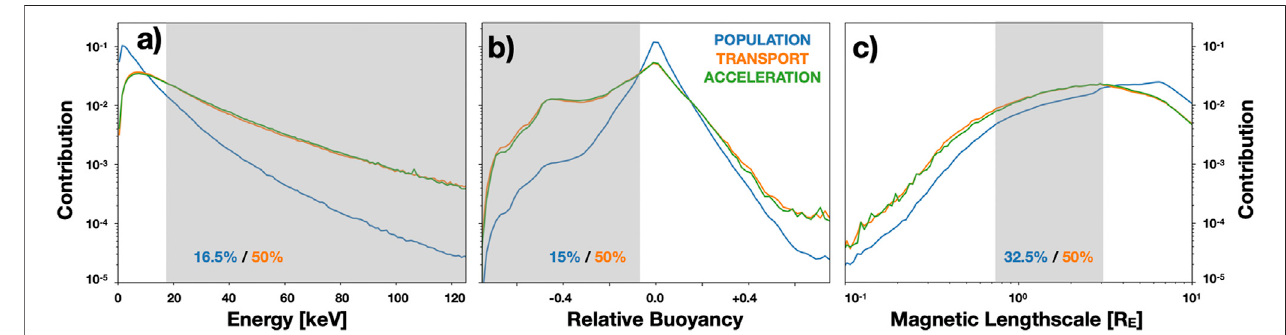
FIGURE 4 | Ef fi ciency of transport and acceleration in the transition region. Here we compare for various particle and fl ow properties their fraction of: the total population,thetotalinwardenergytransport,andthetotalenergizationasde fi ned in Section2.3 .Regionswhere thecontributionofaquantitytotransport/acceleration is greater than population are “ ef fi cient ” for ring current buildup. Shown are particle energy (A) , relative buoyancy Eq. (2) ; (B) , and magnetic lengthscale Eq. (4) ; (C) . In each panel the shaded region is chosen to highlight approximately 50% of the total energy